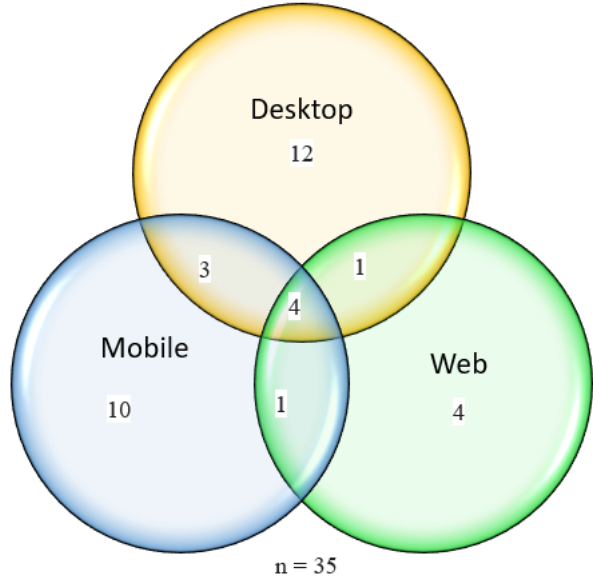
Figure 8. OST delivery types of primary